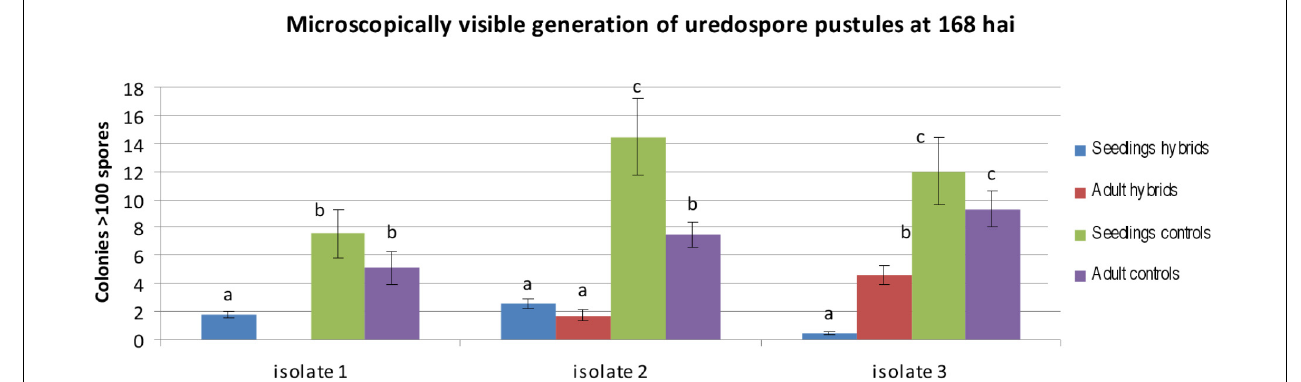
FIGURE 5 | Statistical analysis of microscopically visible generation of uredospore pustules of hybrids carrying leaf rust resistance genes (hybrids) and control plants (controls) inoculated with single spore isolates at 168 hai at the seedling and adult plant stage. The bars represent a mean value (over replications) and error bars represent standard errors. The letters indicate homogenous groups of means that do not differ significantly at a significance level of 0.05 (Fisher’s LSD-test). TABLE 2 | The effectiveness of androgenesis induction and doubled haploid production from three monosomic 2D addition plants of triticale. Plant Androgenic structures Green plants Plants for colchicine